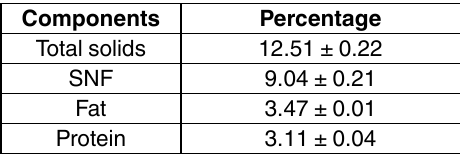
table 1. Composition 1 of milk offered to the